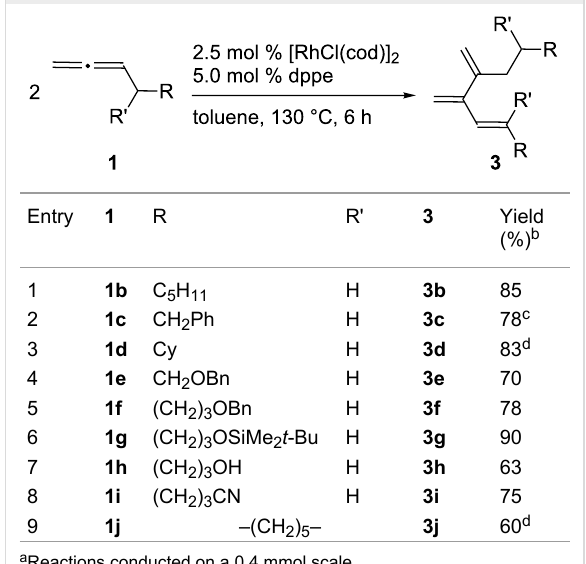
Table 2: Synthesis of cross-conjugated trienes by the allene dimeriza- tion reaction a